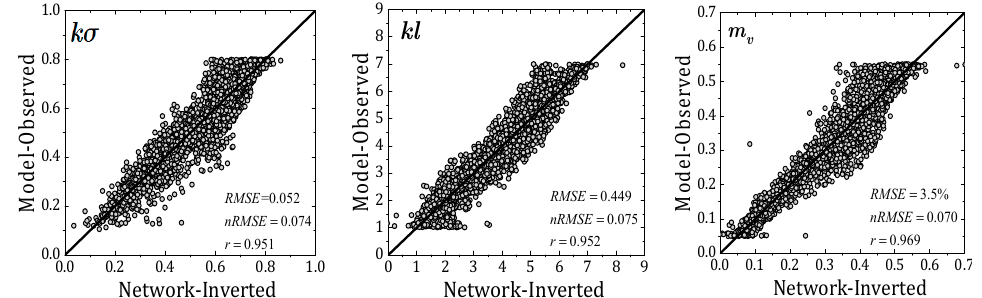
Figure 10. Retrieval of surface roughness and soil moisture from backscattering data by three inputs – three outputs DLNN configuration. Both root-mean-squared errors (RMSE) and normalized root-mean-squared errors (nRMSE) for each case are shown.